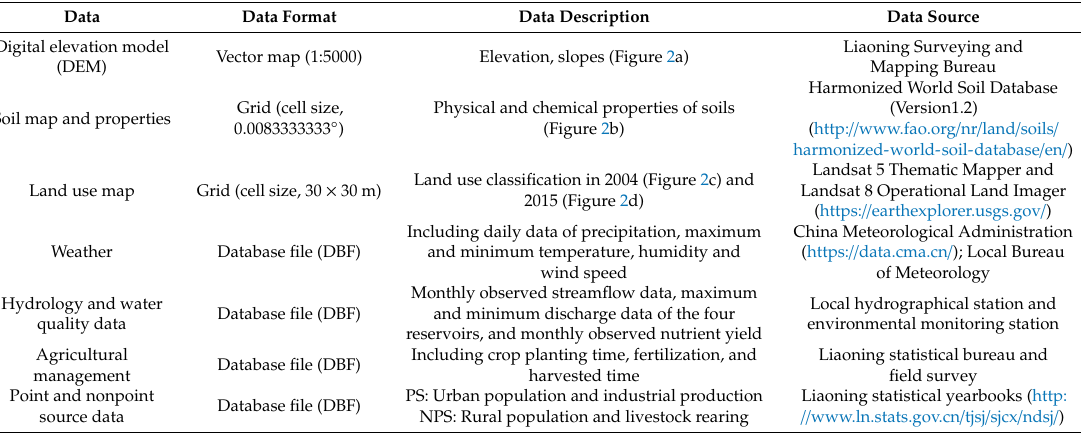
Table 1. Soil and Water Assessment Tool (SWAT) model